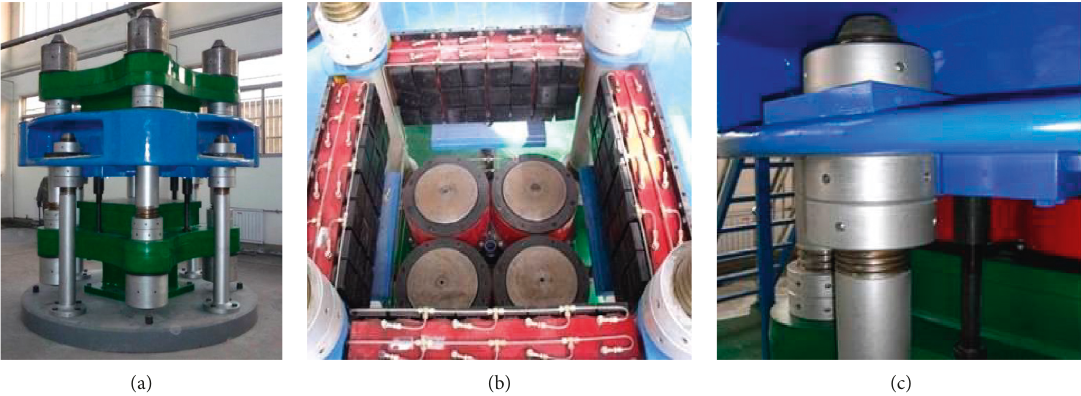
Figure 1: The main equipment used in the test system to monitor crack propagation and tunnel failure. (a) Key equipment. (b) Loading system. (c) The bearing system.